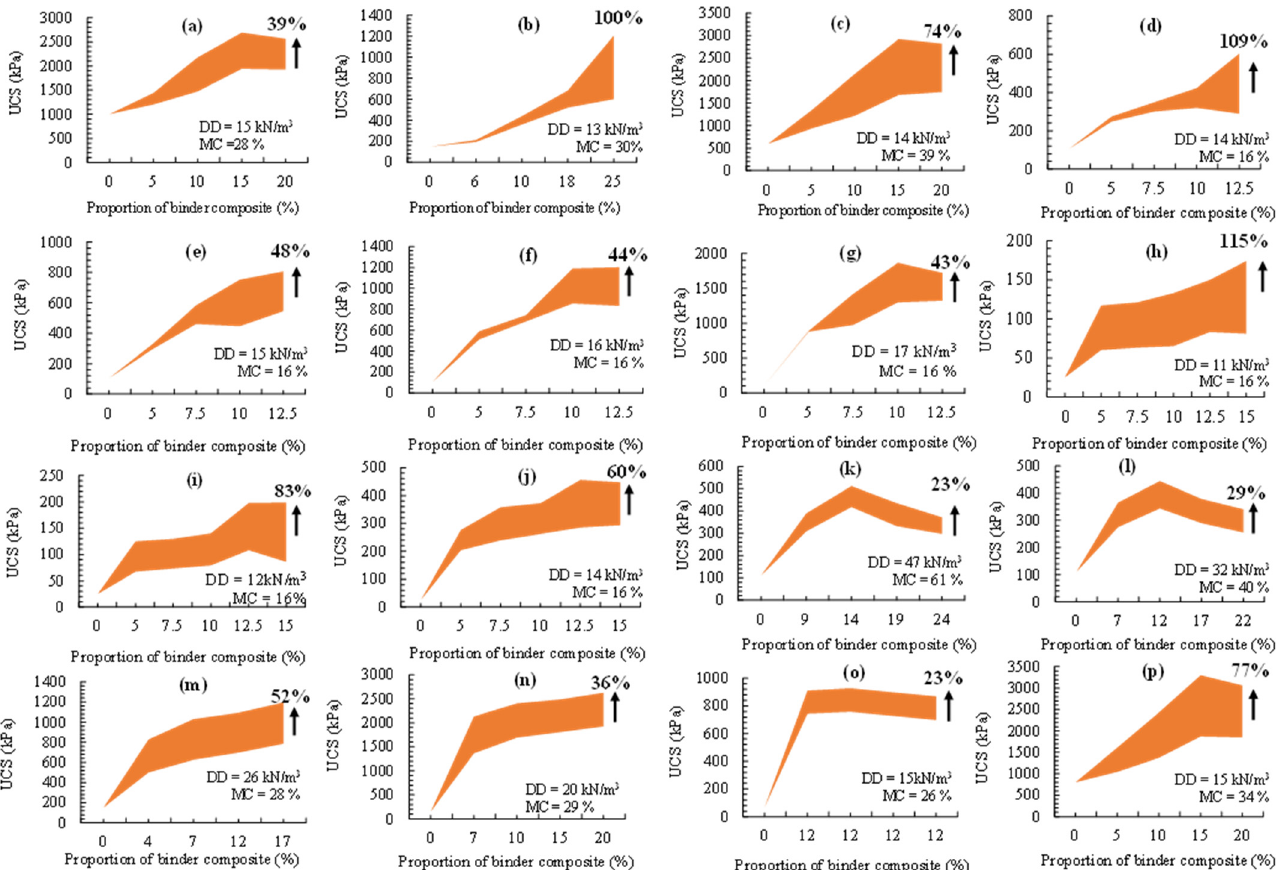
Figure 3. Variation of UCS of stabilised soils with duration and binder proportion. ( a ) 39% increase in UCS; ( b ) 100% increase in UCS; ( c ) 74% increase in UCS; ( d ) 109% increase in UCS; ( e ) 48% increase in UCS; ( f ) 44% increase in UCS; ( g ) 43% increase in UCS; ( h ) 115% increase in UCS; ( i ) 83% increase in UCS; ( j ) 60% increase in UCS; ( k ) 23% increase in UCS; ( l ) 29% increase in UCS; ( m ) 52% increase in UCS; ( n ) 36% increase in UCS; ( o ) 23% increase in UCS; ( p ) 77% increase in